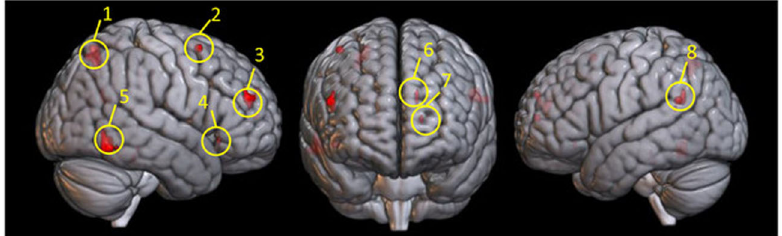
Fig. 4 Factors locations associated with the post-classical end of the classical vs. post-classical dimension (i.e. those whose activation was increased for post-classical concepts). The factor clusters are encircled and numbered for ease of reference in the text and their centroids are included in Table 2. These locations correspond to the four classes of processes evoked by the post-classical concepts.